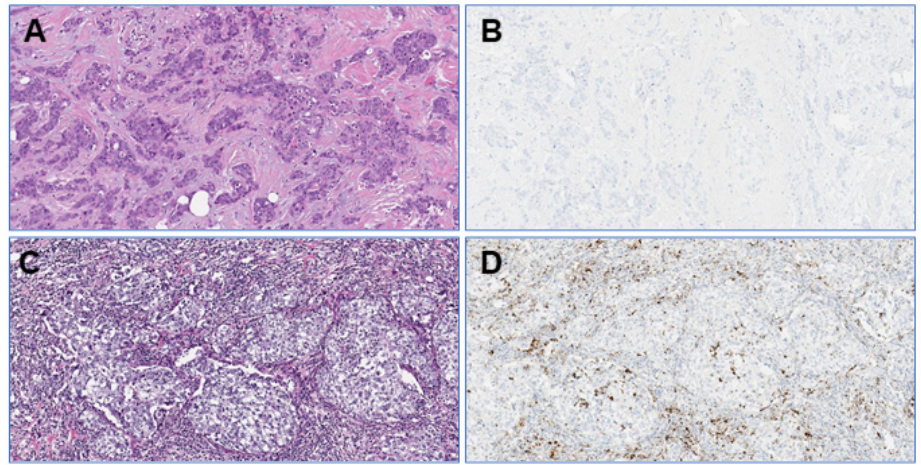
TILs ( A ) and no PD-L1/SP142-positive immune cells ( B ). The stroma of another TNBC shows high